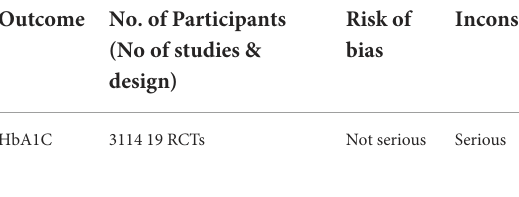
TABLE 2 Summary of findings of HbA1c. Outcome No. of